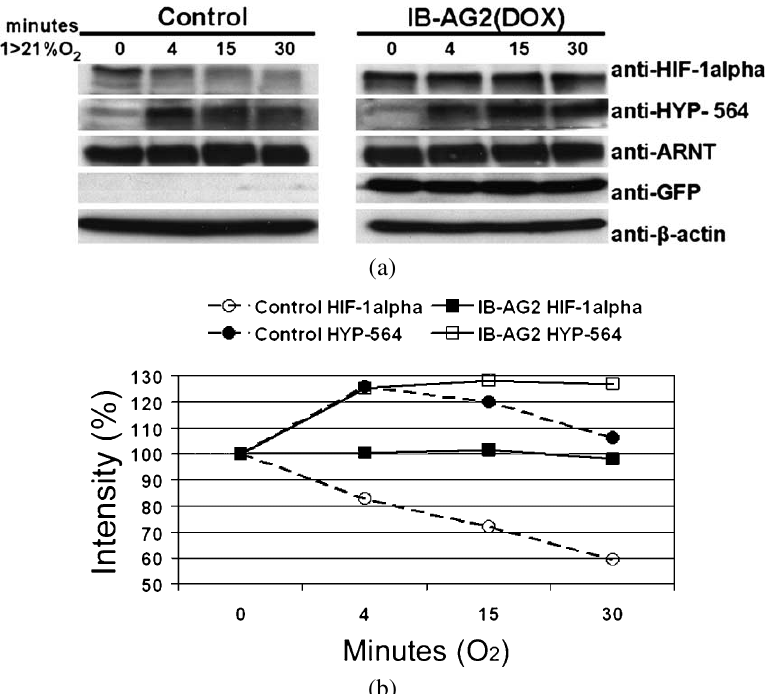
Fig. 7. Prolyl-hydroxylated HIF is stabilized by IB-AG2. (a) Reoxygenation experiment with inducible LS174TR1/IB-AG2 cells with or without doxycyclin. Cells were exposed to hypoxic conditions (1% O 2 ) for 24 h and then reoxygenated (21% O 2 ) for the indicated timepoints after which cell lystaes were prepared. Total cell lysates were immunoblotted and analysed for HIF-1 α , prolyl-hydroxylated HIF-1 α (HYP-564), ARNT and GFP. β -actin is used as loading control. (b) Plotted curves of band intensities for HIF-1 α and hydroxylated HIF-1 α corresponding to immunoblots shown in